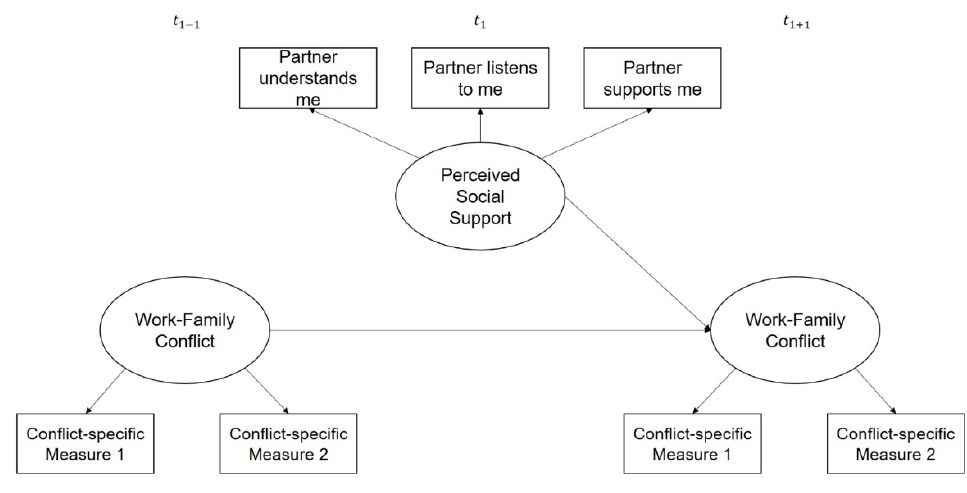
Figure 1 : General model of